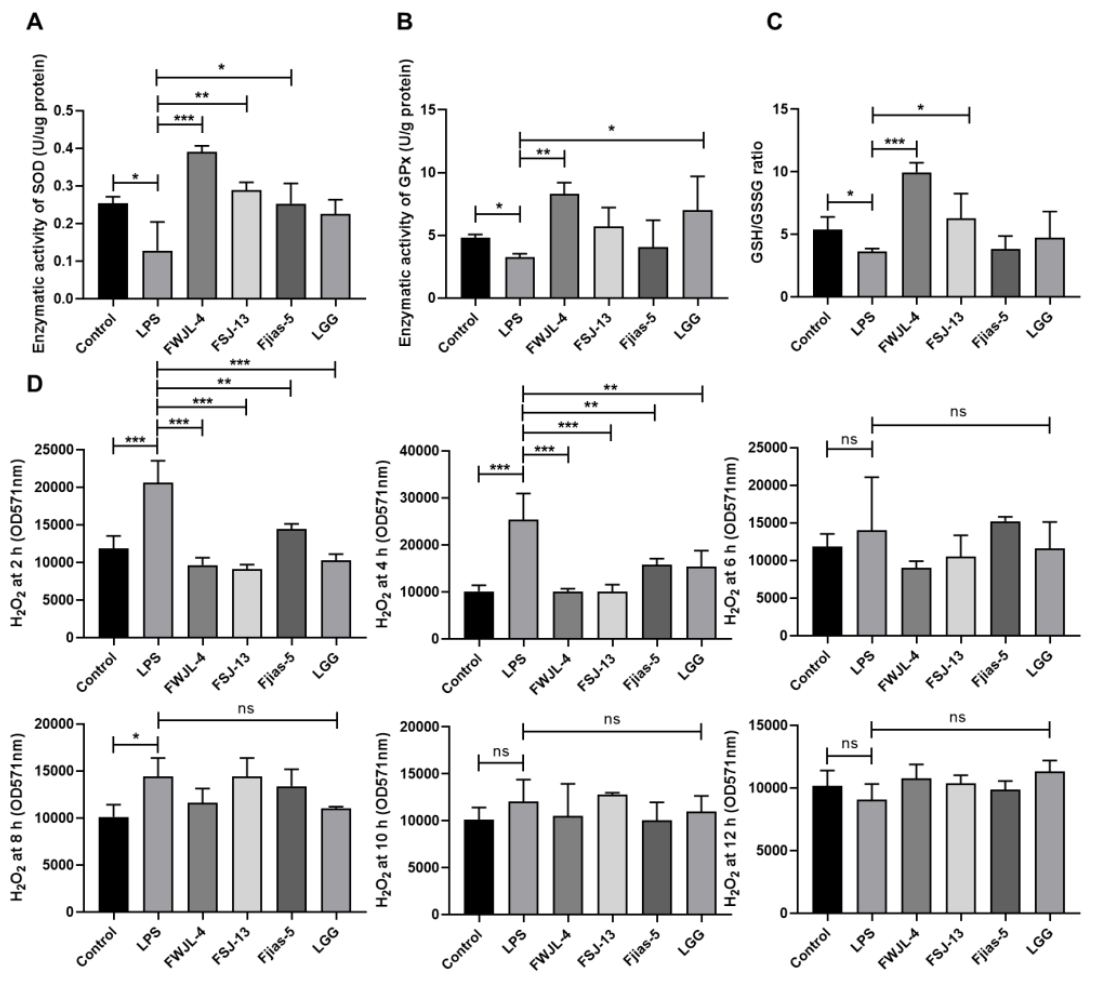
Figure 5. Selected probiotic LAB ( L. gasseri FWJL-4, L. plantarum Fjias-5 and L. rhamnosus FSJ-13) enhance antioxidant enzymes and reduce H 2 O 2 production in LPS-treated RAW 264.7 murine mac- rophages. ( A ) The enzymatic activities of SOD in different groups. ( B ) The enzymatic activity of GPx in different groups. ( C ) The ratio of GSH/GSSG in different groups. ( D ) The generation of cellular H 2 O 2 at 2 h, 4 h, 6 h, 8 h, 10 h and 12 h in different groups. All data were expressed as mean ± SD ( n = 3 independent experiments). Statistical significance was defined as * p < 0.05; ** p < 0.01; *** p < 0.001. “ns”: no significance. Reported statistical sig nificance refers to comparisons with cell-treated with LPS.